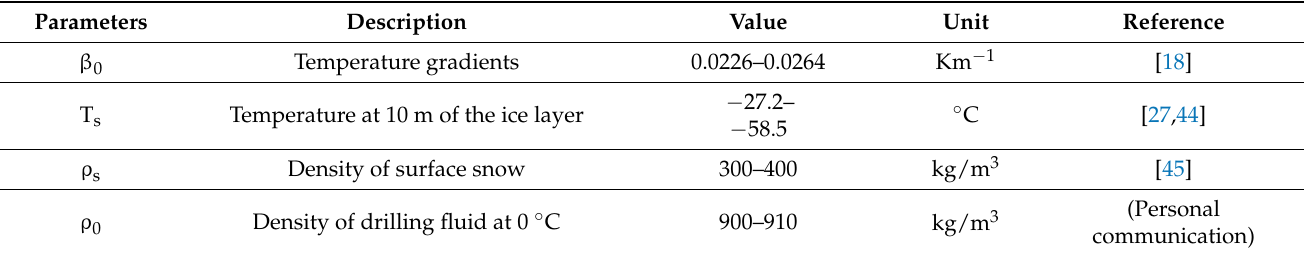
Table 3. Variable